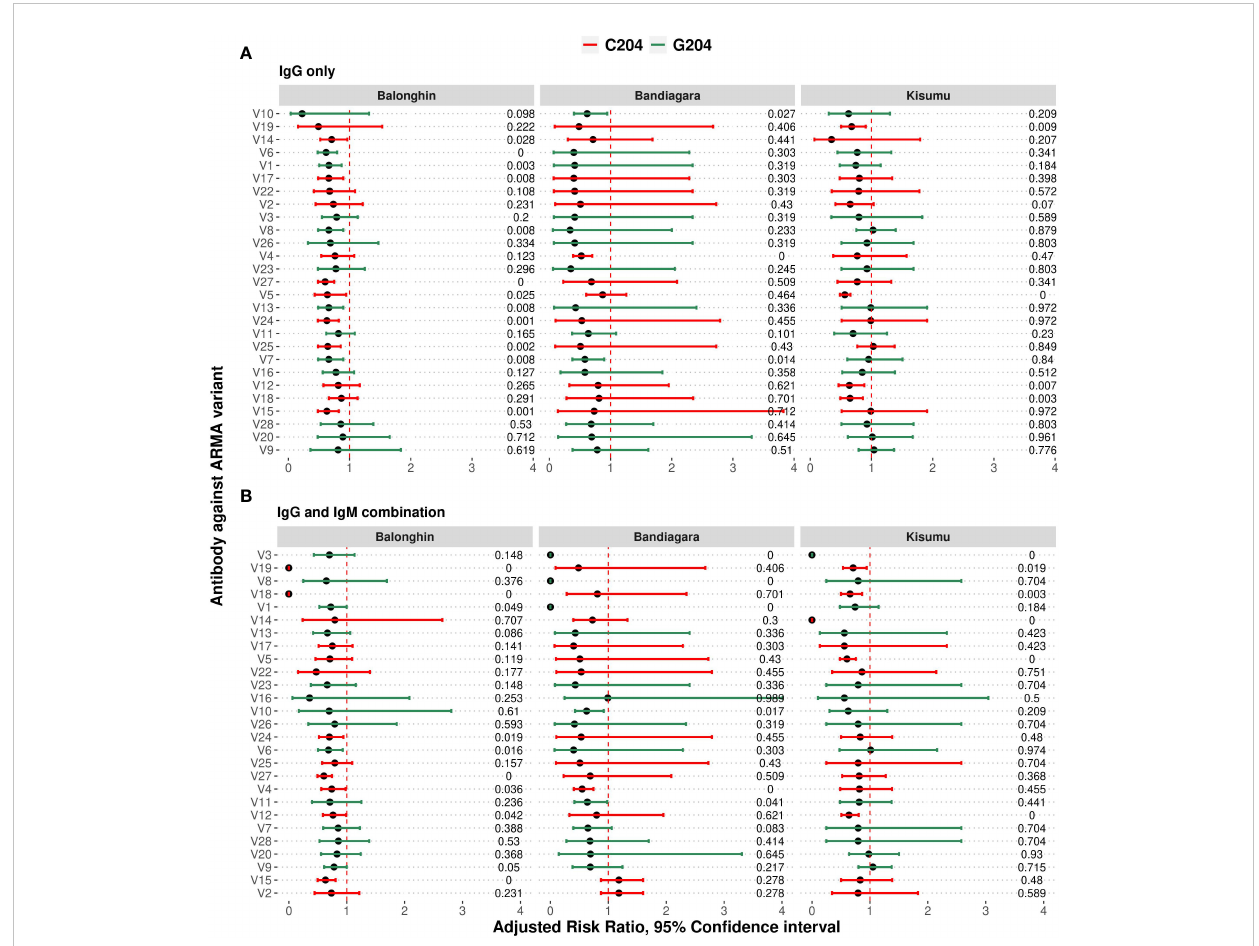
FIGURE 5 Combinations of IgG and IgM antibodies against selected variants of ARMA are associated with protection against clinical episodes of malaria. (A) Associations between IgG antibodies to individual variants and the risk of clinical episodes of malaria. Antibodies against variants containing both C204 and G204 haplotypes were signi fi cantly associated with protection in Balonghin and Bandiagara, but only the former in Kisumu. (B) Combinations of IgG and IgM antibodies to at least two variants were associated with a 100% reduction in the risk of malaria in all three geographical locations; V18 and V19 in Balonghin, V1, V3 and V8 in Bandiagara, and V3 and V14 in Kisumu. Figures on right represent P-values, red and green represent haplotype families C204 and G204,